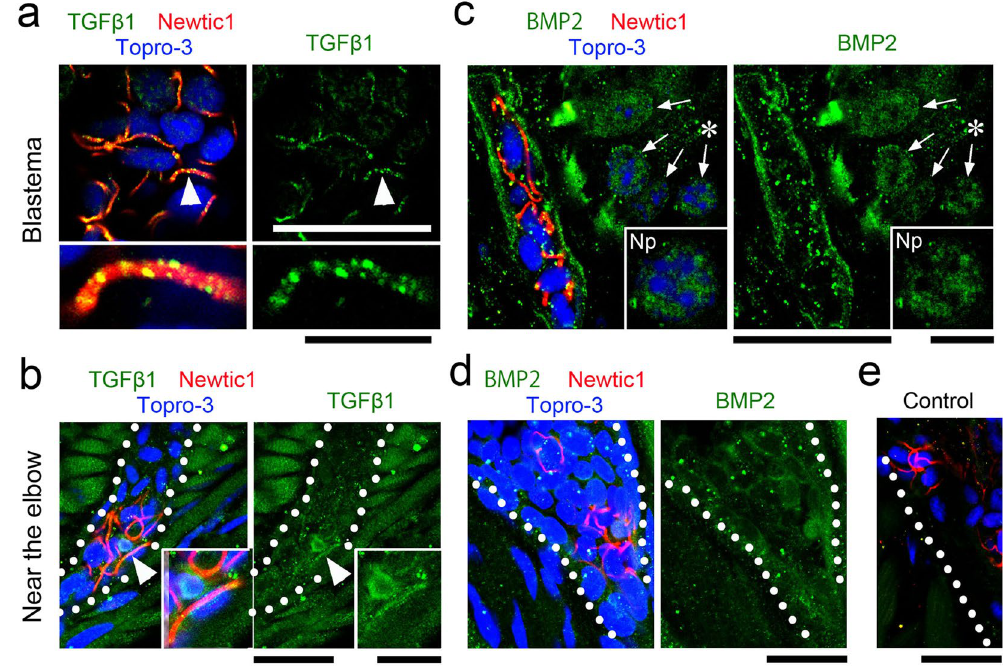
in a transitional stage from stage II to stage III. Intense TGF β 1 immunoreactivity was observed in a large number of dots located along the equatorial plane of most PcNobs, though the cytoplasm of PcNobs exhibited weak immunoreactivity. A sample indicated by the arrowhead was enlarged in the lower panel. Topro-3: nucleus. Scale bars, 50 μ m (upper) and 10 μ m (lower). ( b ) Representative image showing TGF β 1 expression in PcNobs circulating along the thick blood vessels near the elbow (n = 3). The section was obtained from the same limb in ( a ). Dotted lines show the vessel wall. TGF β 1 immunoreactivity in PcNobs was substantially the same as that observed in blood cell suspensions (Fig. 7a), though it was difficult to recognize differences in immunoreactivity between EryCs and free Newtic1-negative PcNobs. Inset: enlarged image of the equatorial plane of PcNob (arrowhead). Scale bars, 50 μ m and 10 μ m (inset). ( c ) Representative image showing BMP2 expression in EryCs in a growing blastema (n = 3). The section was obtained from a regenerating limb in the transitional stage from stage II to stage III. BMP2 immunoreactivity in the cytoplasm of PcNobs obviously declined while intense immunoreactivity was observed in small dots distributed around the PcNobs as well as along the wall of regenerating capillaries/vessels. Arrows: neutrophil (NP) which exhibited BMP2 immunoreactivity in its cytoplasm. Inset: enlargement of the neutrophil (asterisk). Scale bars, 50 μ m and 20 μ m (inset). ( d ) Representative image showing BMP2 expression in PcNobs circulating along thick blood vessels near the elbow (n = 3). The section was obtained from the same limb in ( c ). Dotted lines show the wall of the vessel. BMP2 immunoreactivity in PcNobs was substantially the same as that observed in blood cell suspensions (Fig. 7b). Scale bars, 50 μ m. ( e ) Example showing control immunoreactivity with Newtic1 (red) and RFP (green) antibodies (n = 3). The image shows tissues near the elbow. Dotted lines show the vessel wall. The section was obtained from the same limb in ( c , d ). Scale bars, 50 μ